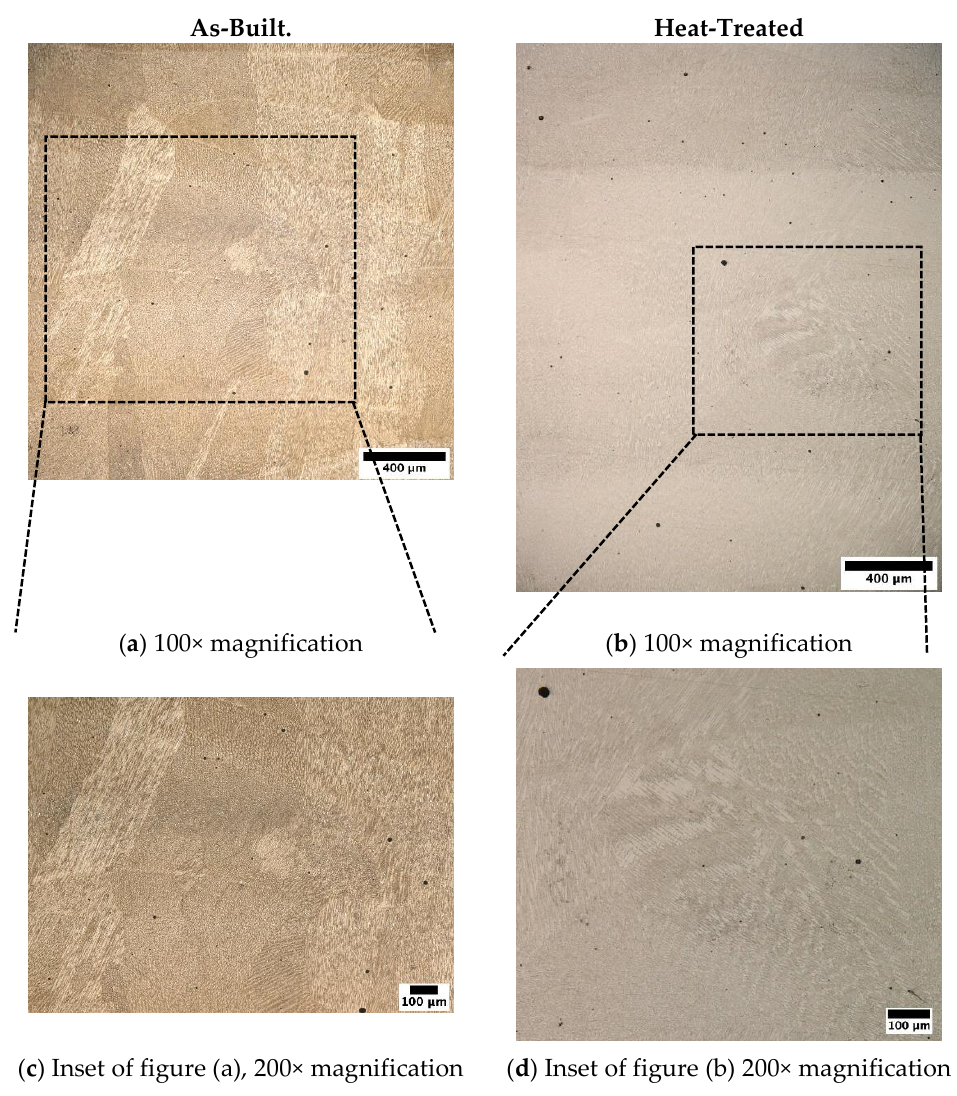
Figure 5. Light optical microscopy images of etched LMD samples in the as-built and heat-treated state. treated